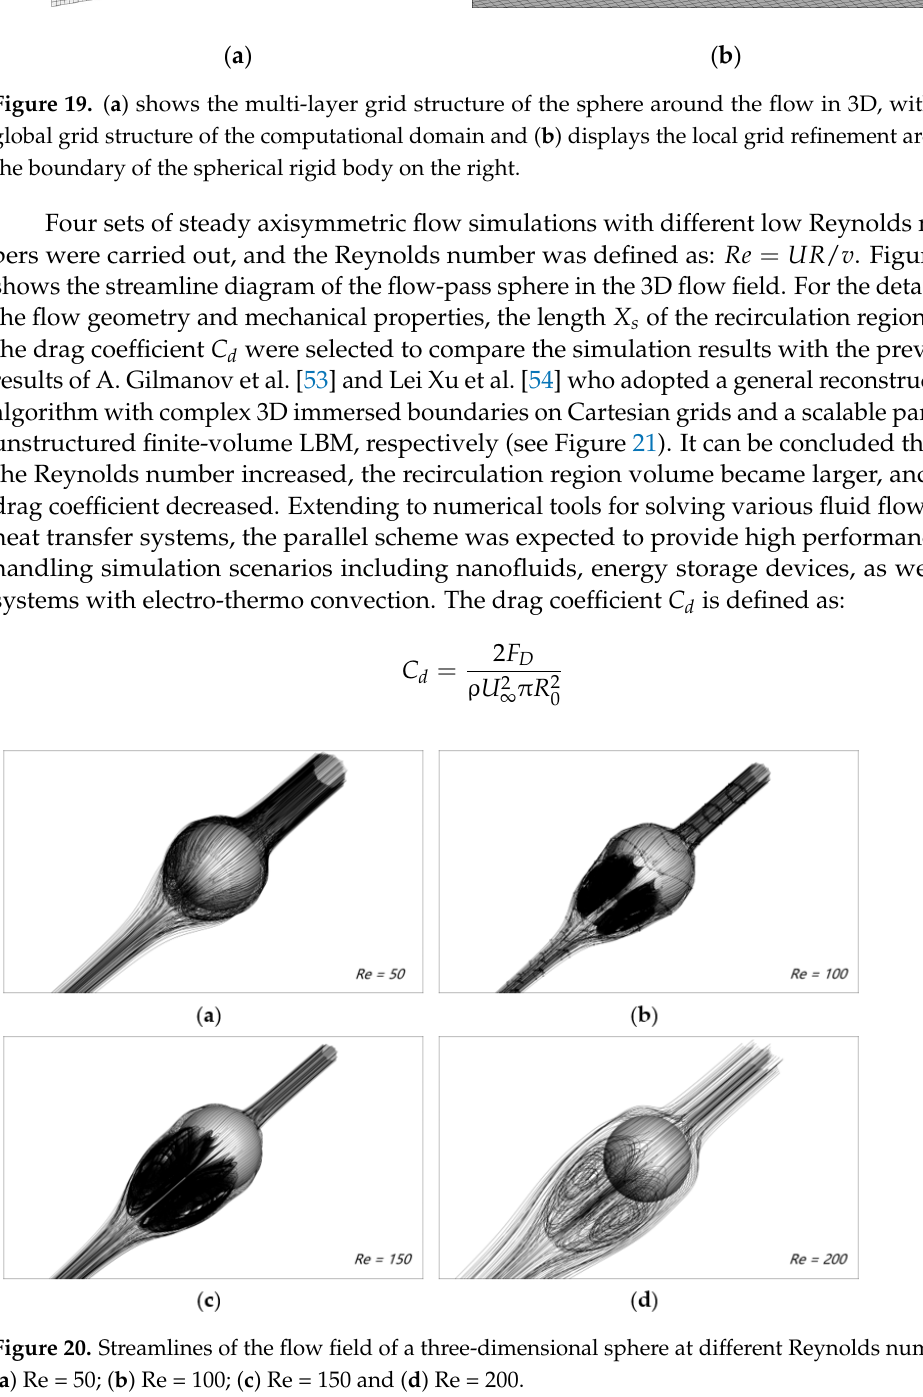
( a ) Re = 50; ( b ) Re = 100; ( c ) Re = 150 and ( d ) Re =